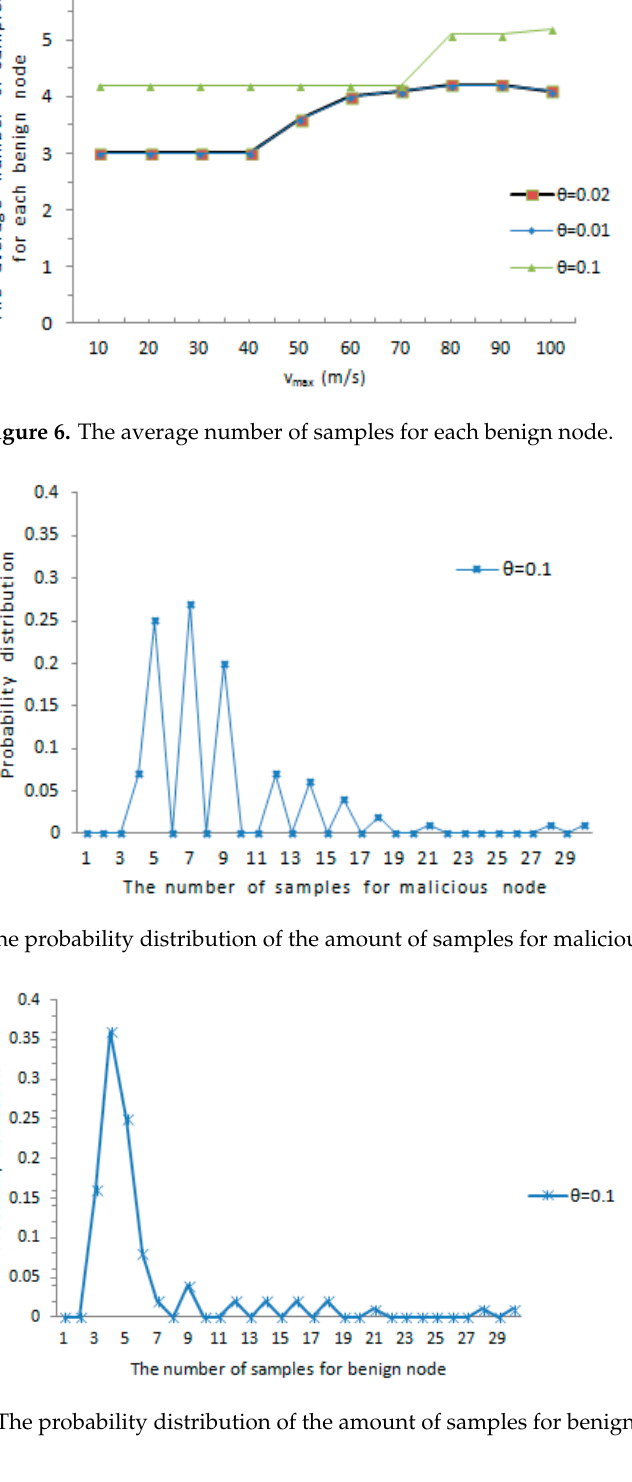
Figure 5. The average number of samples for each malicious node.